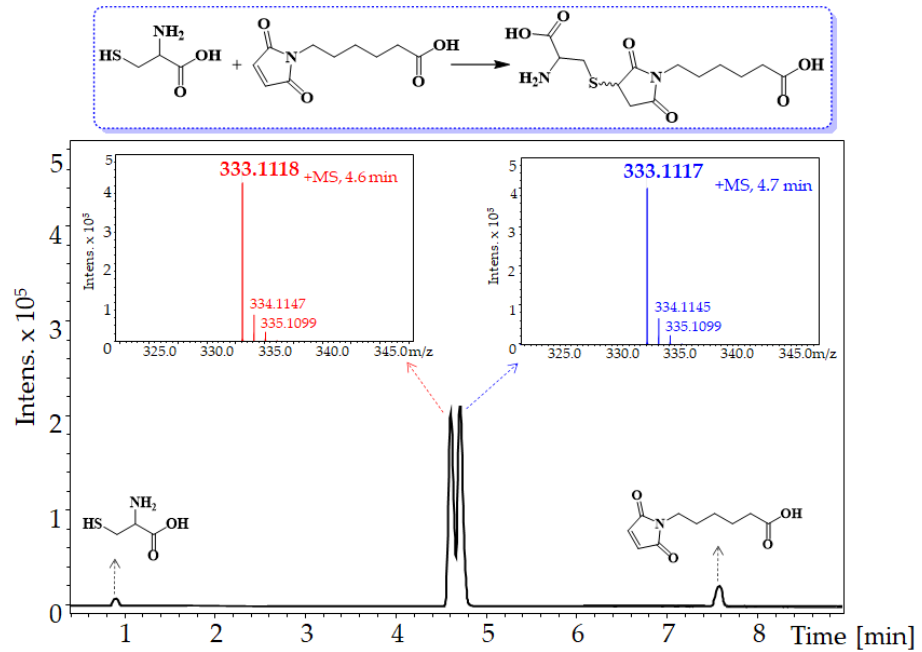
Figure 2. Analysis of the reaction between cysteine (Cys) and 6-maleimidohexanoic acid (Mhx) in water, by means of LC-MS (ESI). The TIC showed signals at t R : 4.6 and 4.7 min that corresponded to the reaction’s